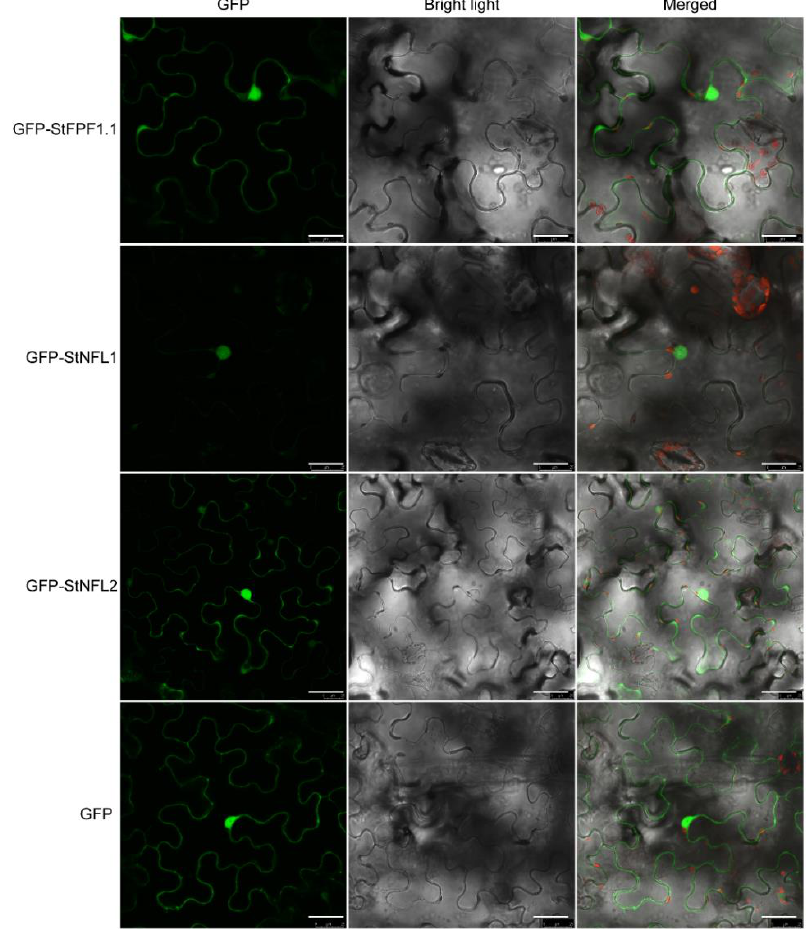
Figure 3. Subcellular localization analysis of the StSP6A interactors. The GFP alone and fusion proteins were transiently expressed in N. benthamiana leaves via agrobacterium. After 48 h, the GFP fluorescence signals were captured by a Leica TCS SP8 confocal microscope. GFP alone is localized in the cytoplasm and nucleus. The bar = 25 μm.